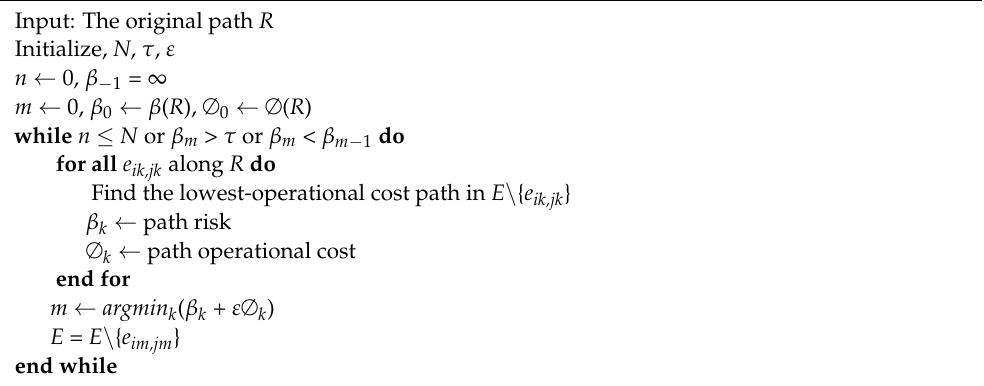
Algorithm 1: Iterative Risk Reduction (IRR), suboptimal solution to P4.